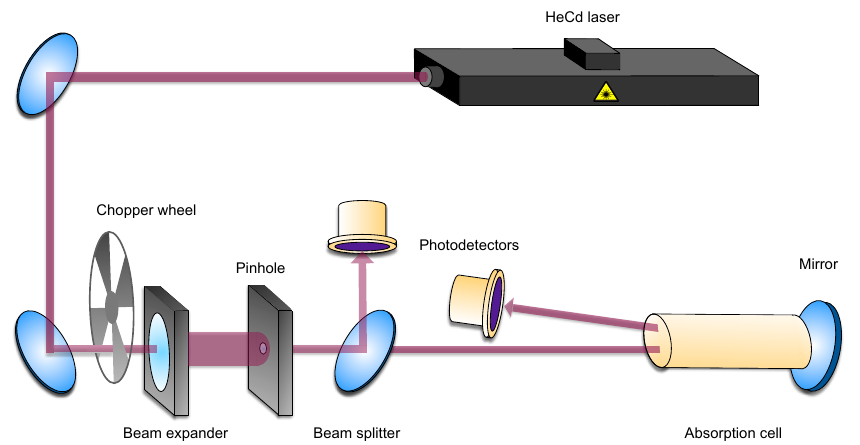
Figure 2. Scheme of the optical system. The beam of a HeCd laser is chopped, widened and directed through a pinhole before impinging on a beam splitter. The reflected beam provides the reference signal for the correction of laser intensity fluctuations. The transmitted beam passes through the absorption cell twice before being registered by a photodetector. Cell windows are slightly inclined with respect to the optical axis.